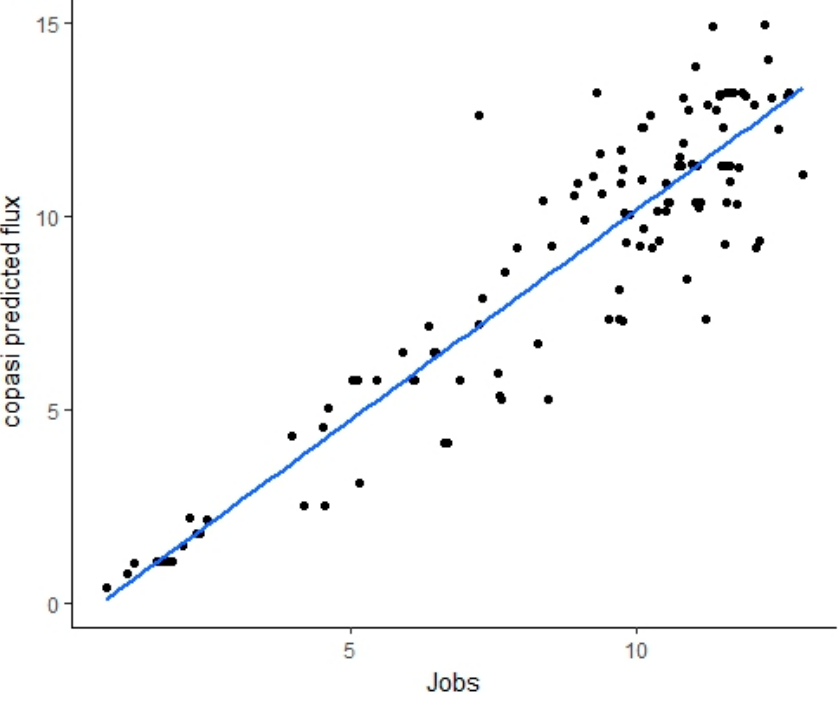
Figure 7. Relationship between experimental flux (J Fievet ) estimated by Fievet et al. [43] and COPASI [58] estimated by the kinetic model.